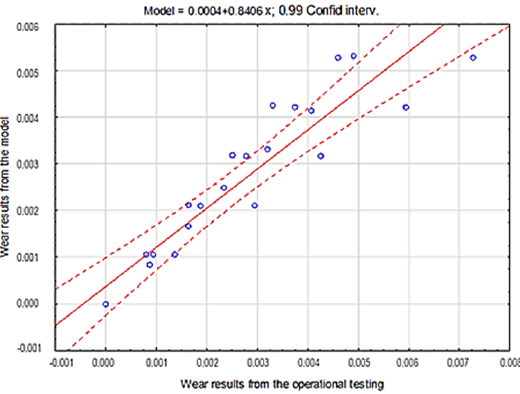
Figure 16. The course of the correlation of theoretical data with empirical data for steel in light soil.